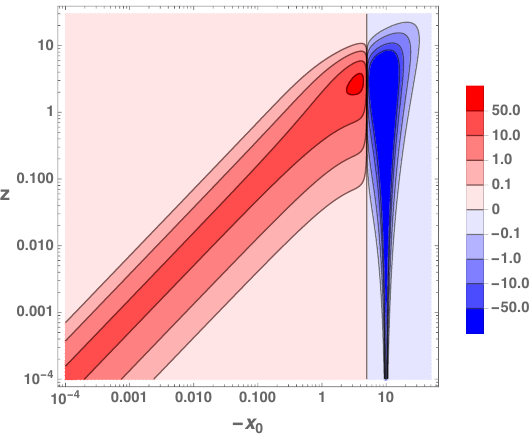
Figure 7 . The topological charge density (3.36) (multiplied by the volume factor 4 πx 4 ) for d = 10 . The contours are drawn for x 0 < 0 and x 1 = x 2 = x 3 = 0 and depict an antimeron appearing at x 0 = − 10 whose size grows with increasing z and annihilates the meron located at x 0 = 0 whose size also grows with increasing z . The topological charge density is zero when x 0 = − d/ 2